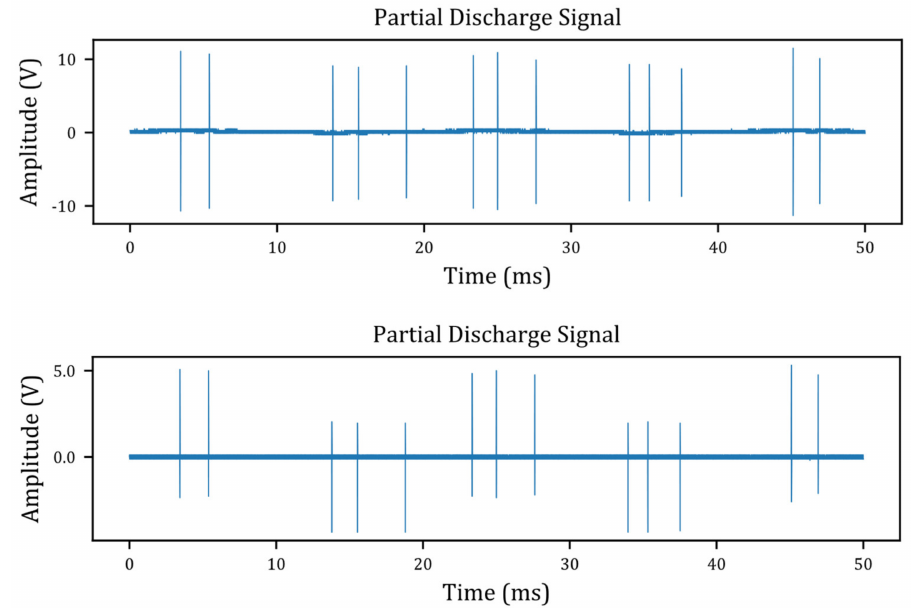
Figure 5. Examples of partial discharge signals collected during laboratory tests using a radiofrequency antenna ( top ) and using an HFCT ( bottom